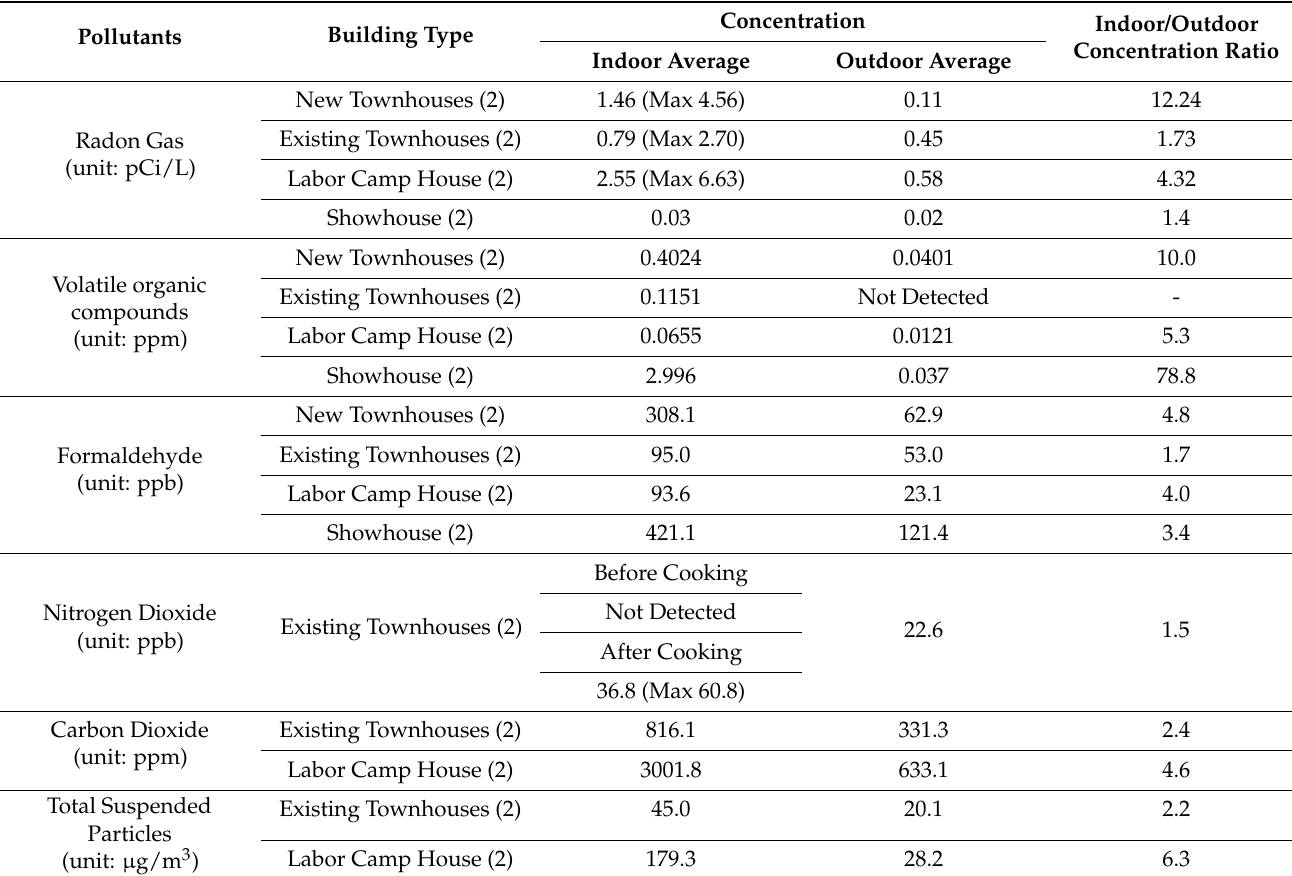
Table 2. Air pollutants concentration